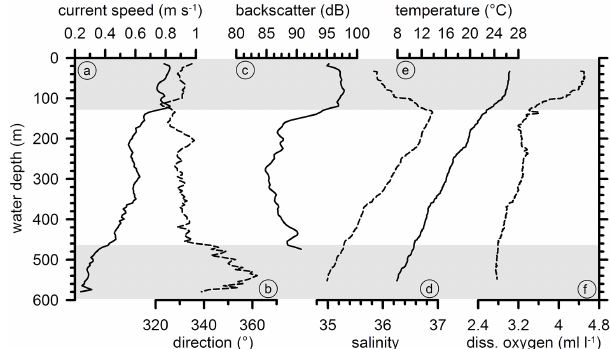
Fig. 8. Water column data for the Yoyo CTD site GeoB 16316. Mean values for (a) current speed, (b) current direction, and (c) backscatter averaged from the 13 h stationary ADCP measure- ment. CTD data from cast GeoB 16316-1 for (d) salinity, (e) tem- perature, and (f) dissolved oxygen. The dashed lines refer to the lower x axes. The grey shadings delineate the different layers of the water column as derived from the ADCP